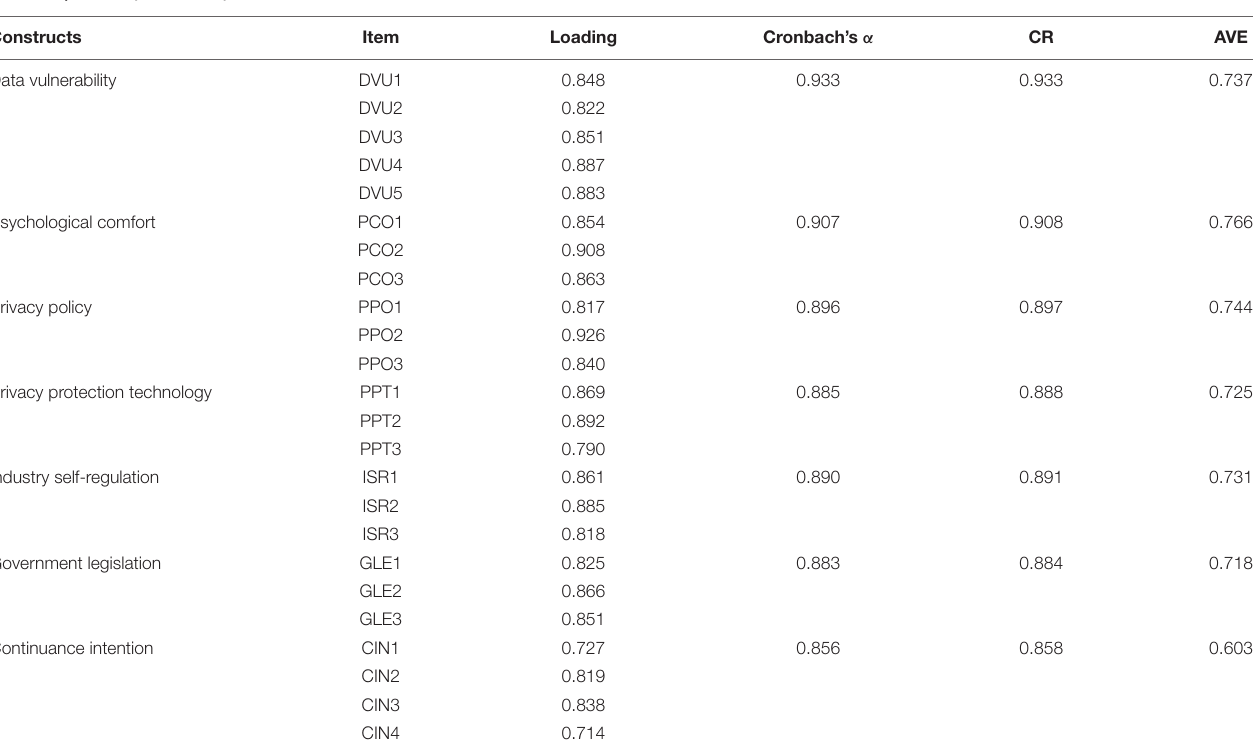
TABLE 3 | Reliability and